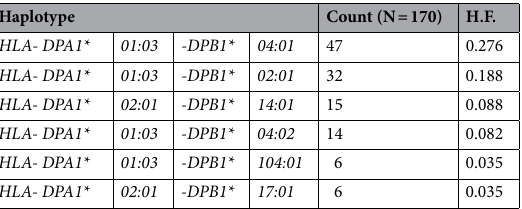
Table 5. Six most frequent HLA-DPA1-DPB1 two-locus haplotype counts observed in the UAE cohort. H.F.: haplotypes frequency.